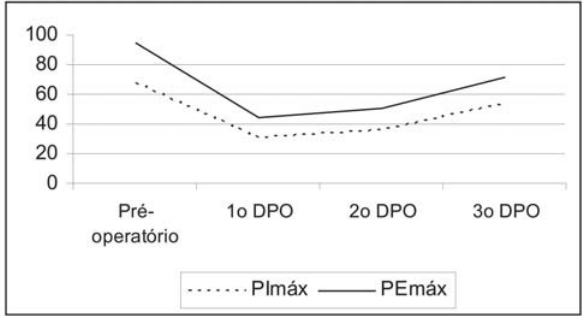
Fig. 2 – Comportamento das médias dos valores de PImáx e PEmáx ao longo dos dias de avaliação, em cmH